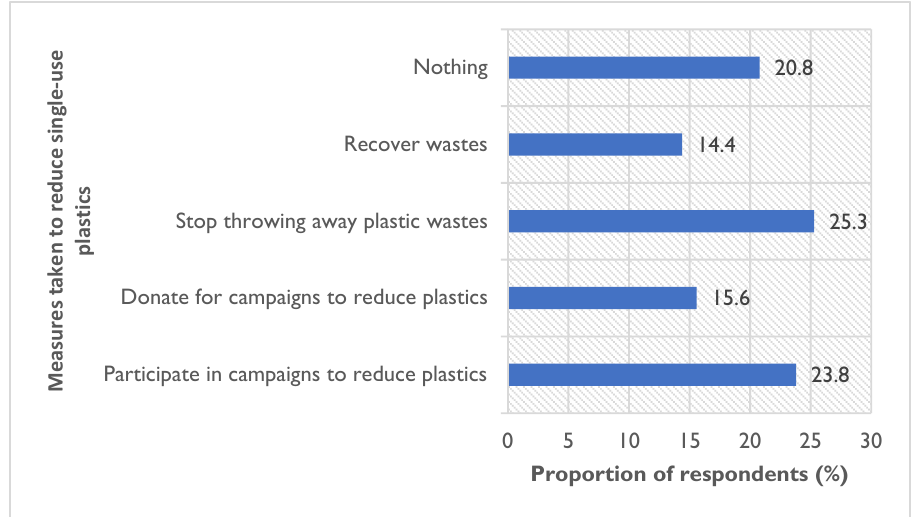
Figure 3. Measures taken to reduce single-use plastic pollution.